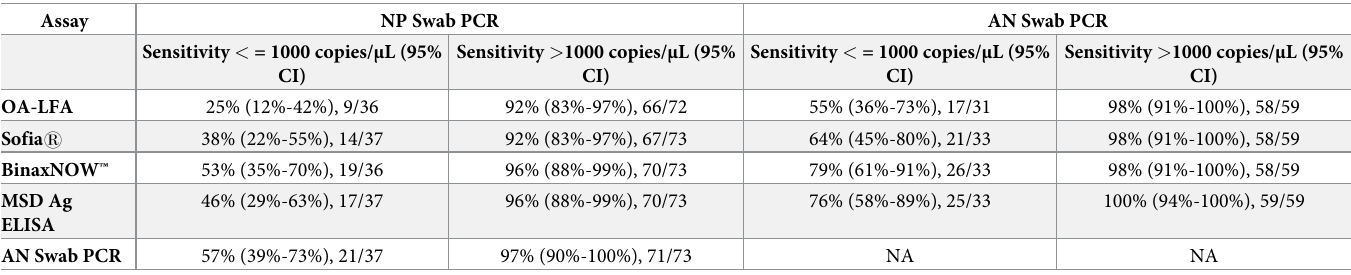
Results are binned into two groups based on if the reference method measured less than or equal or above 1000 copies per